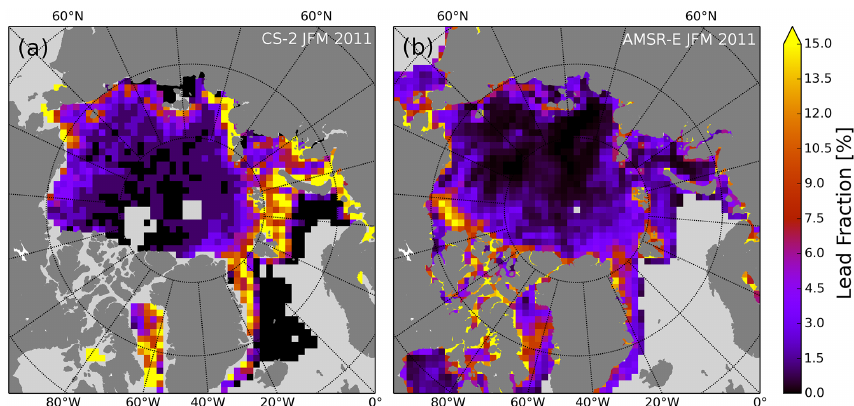
Figure 8. Lead fraction derived from CS-2 SAR mode (a) and from Röhrs et al. (2012) (b) on a north polar stereographic grid with a resolution of 99 . 5km × 99 . 5km, merged from January to March 2011. Only values based on at least 2000 CS-2 measurements north of 65 ◦ N (a) or with a grid cell data coverage of 10% or more (b) are shown. Missing CS-2 estimates north of Canada are caused by the use of the SARIn mode in the Wingham Box.